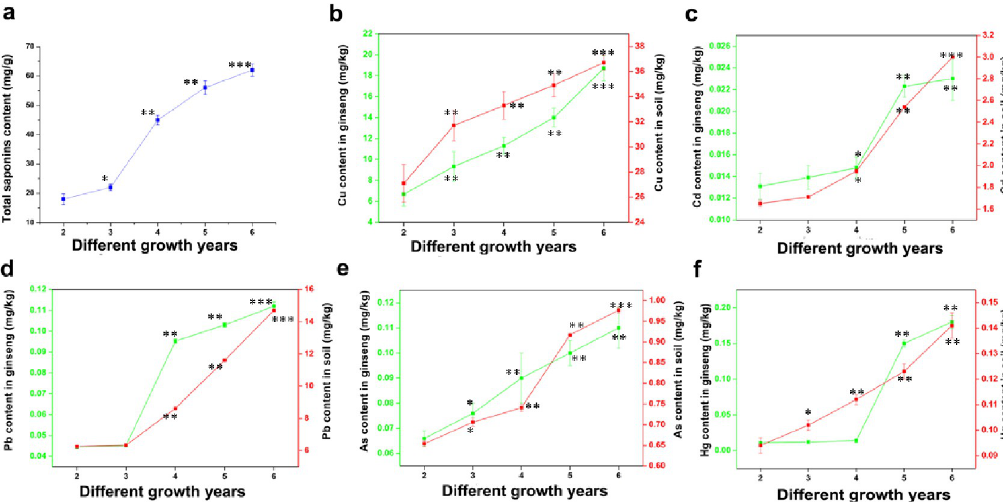
Fig 2. Contents of total ginsenosides and five heavy metal elements (Cu, Cd, Hg, As, Pb) in annual samples. The green Y axis on the left represents the content of heavy metal elements in ginseng, and the red Y axis on the right represents the content of heavy metal elements in ginseng soil. a: Changes in the content of total ginsenosides of ginseng in 2–6 years. b~f: changes of heavy metals Cu, Cd, Pb, As, Hg in Ginseng and its growing soil in 2–6 years; � p < 0.05 vs 2 years, �� p < 0.01 vs 2 years, ��� p < 0.001 vs 2